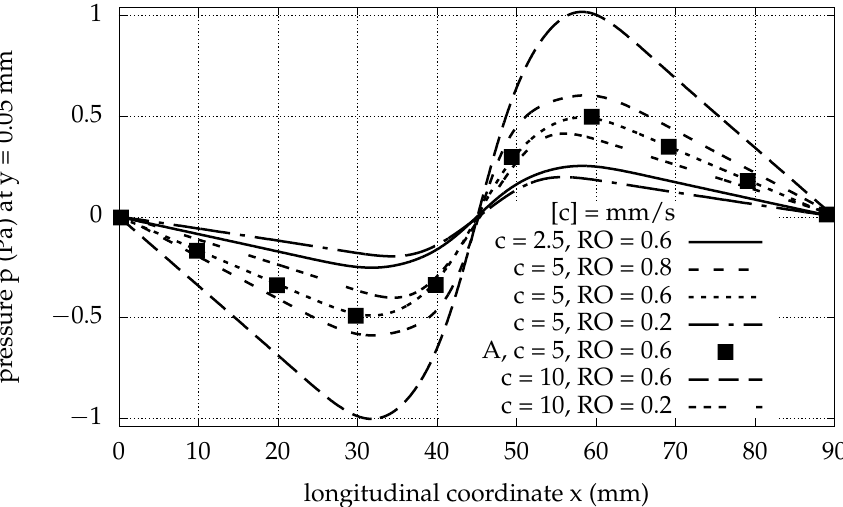
Figure 3. Pressure near the central axis of the pump ( y = 0.05 mm) for various values of RO and c , n = 1 and one roller. Comparison with existing results (A: Data from [12]) is